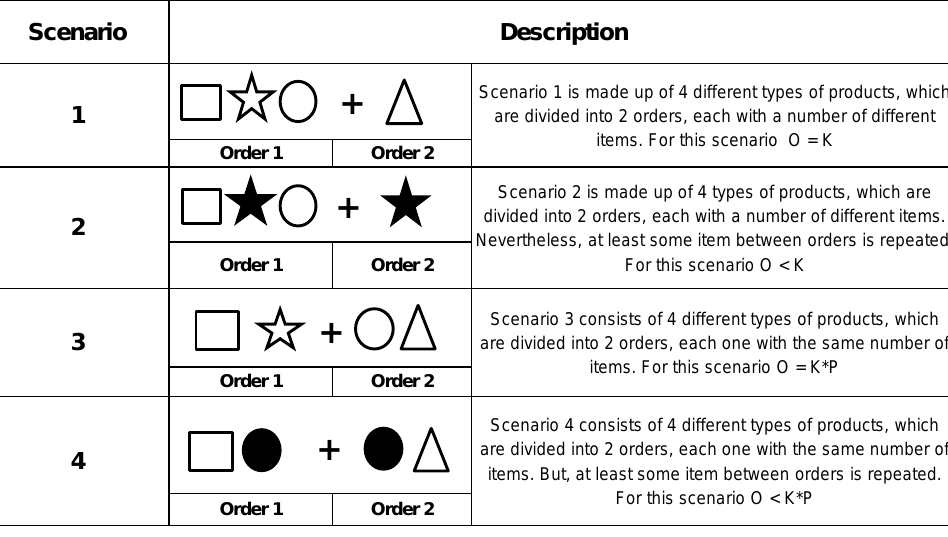
Figure 3. Scenario